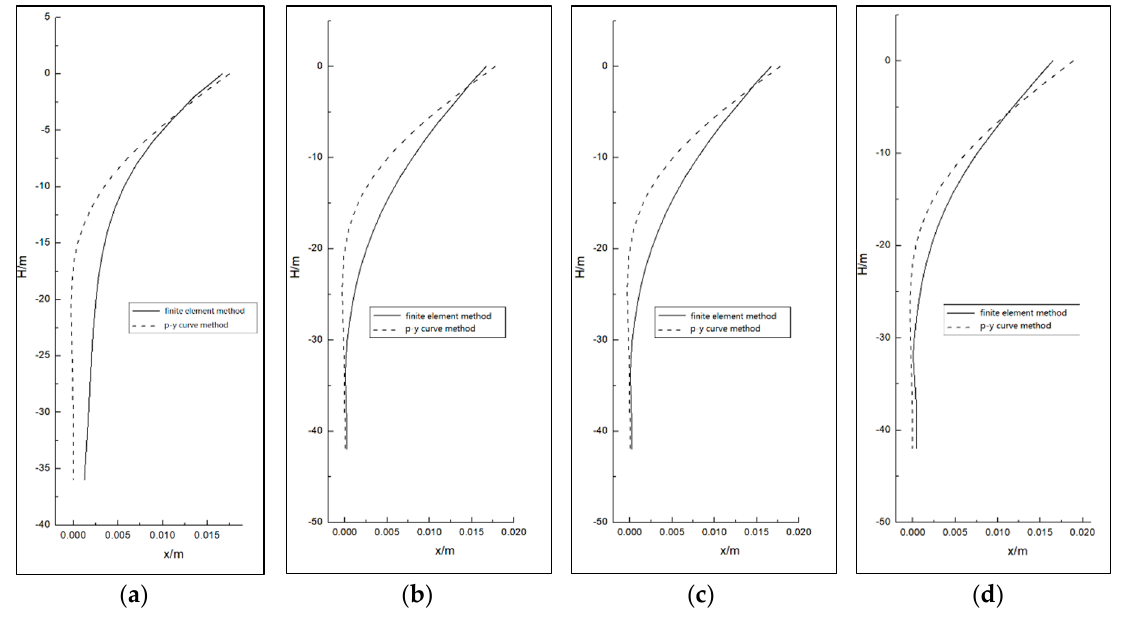
Figure 18. Pile displacement behavior: ( a ) inclined pile; ( b ) front pile; ( c ) middle row pile; ( d ) back pile.